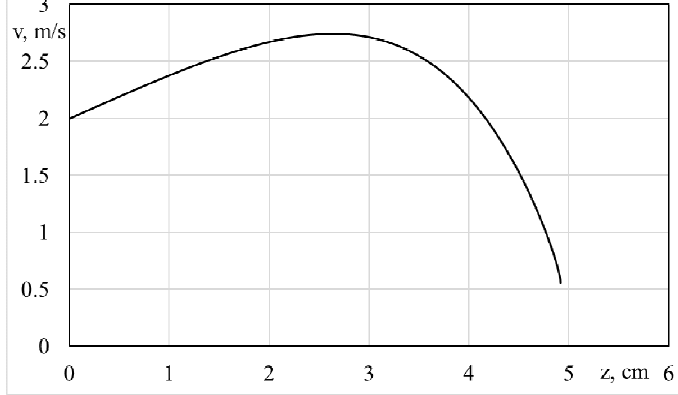
Fig. 4. The velocity of the water along the channel. Initial depth is 1 mm.